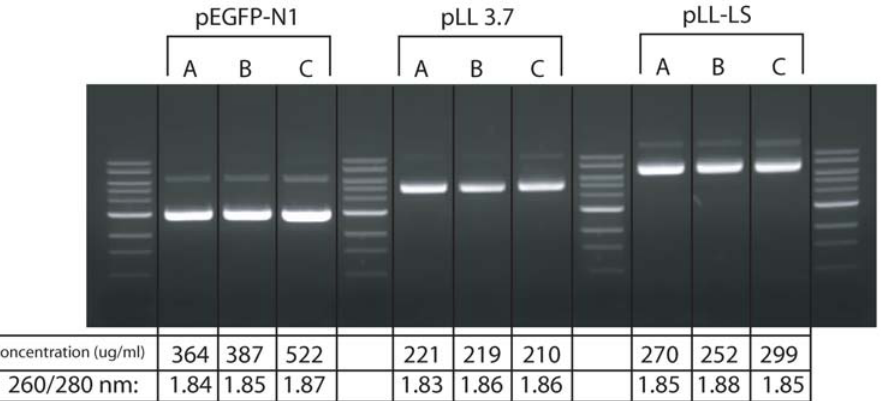
Figure 4. Comparison of plasmid yield using different purification and precipitation methods. Bacterial cultures of each plasmid were divided into three equal portions. The first was purified using the Qiagen Maxi prep kit, and the plasmid eluted from the column was precipitated by isopropyl alcohol after overnight incubation at 2 20 u C using centrifugation (Lane A). The second portion was also purified using the Qiagen Maxi prep kit but the plasmid eluted from the column was isolated by glass syringe filter filtration (Lane B). For the last part of the culture, the plasmid was purified by 4 glass syringe filters and harvested by glass syringe filtration. (Lane C). The final volume of all plasmid preparations was 1 ml in TE (pH 8.0) and 5 ul was loaded on to a 0.8% TAE agarose gel.